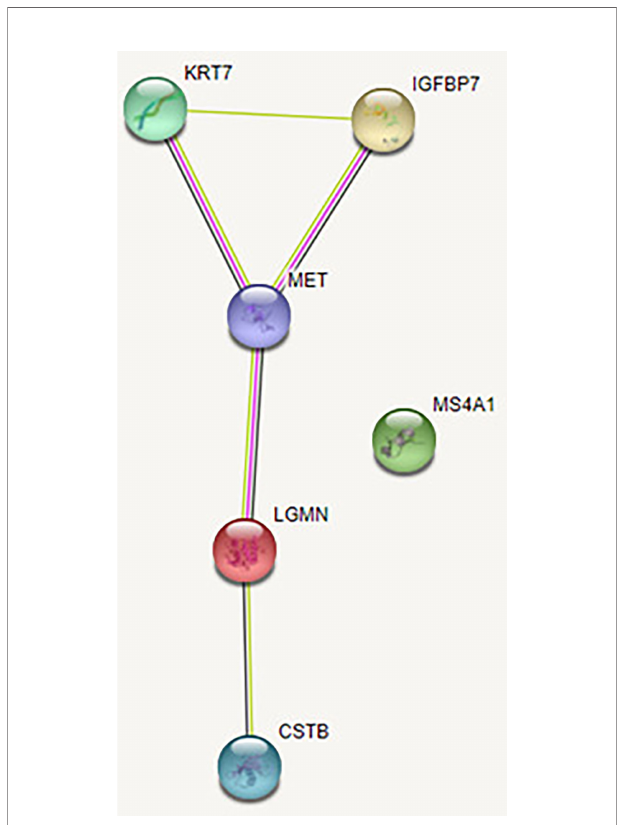
FIGURE 5 | Protein-protein interaction between all investigated proteins. The green line represents the simultaneous mention of related proteins in the published literature. The pink line represents that putative homologs were found interacting in other organisms. The black line represents coexpression of proteins in human or coexpression of their putative homologs in other organisms. Coexpression predicts functional association between the proteins. In our network, there is coexpression between HGF receptor and Legumain and between HGF receptor and CK-7, suggesting their likely signi fi cant functional interaction. Legumain ( LGMN ), IGFBP-7 ( IGFBP7 ), HGF receptor ( MET ), CK-7 ( KRT7 ), Cystatin-B ( CSTB ), CD20 ( MS4A1